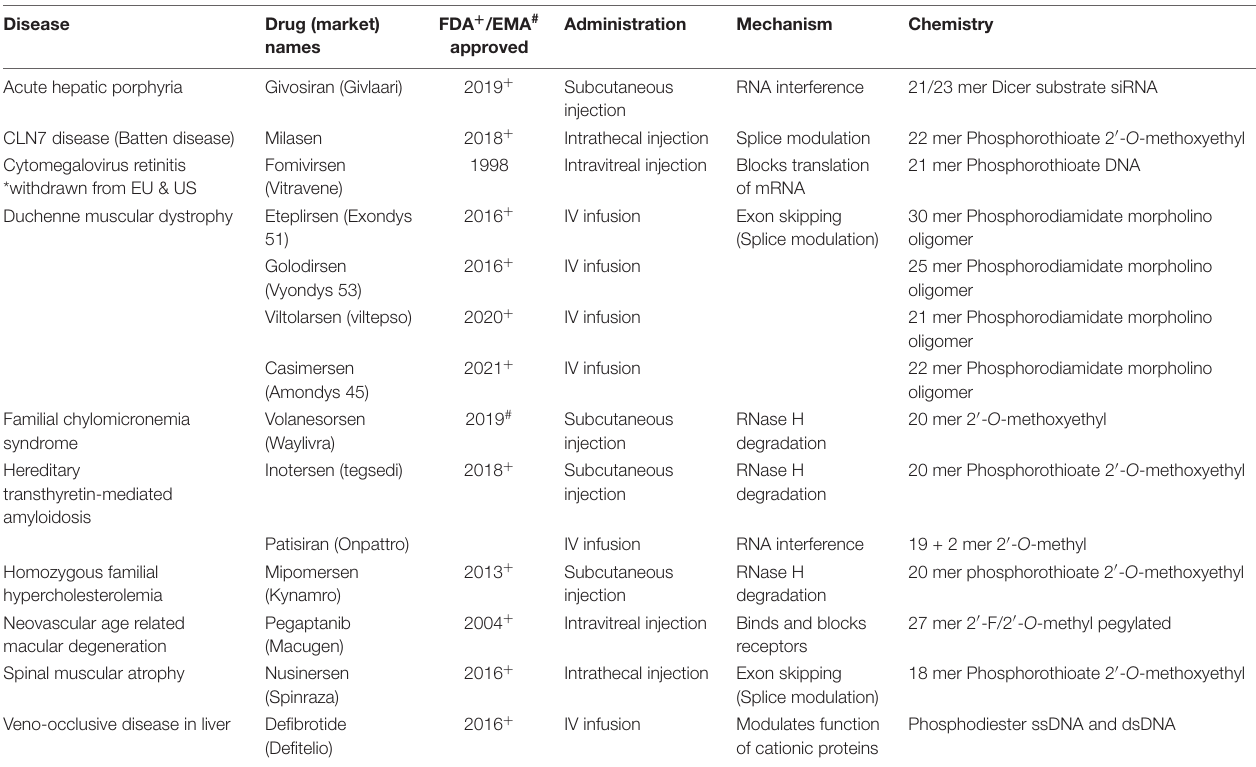
TABLE 1 | Currently approved oligonucleotide therapies.